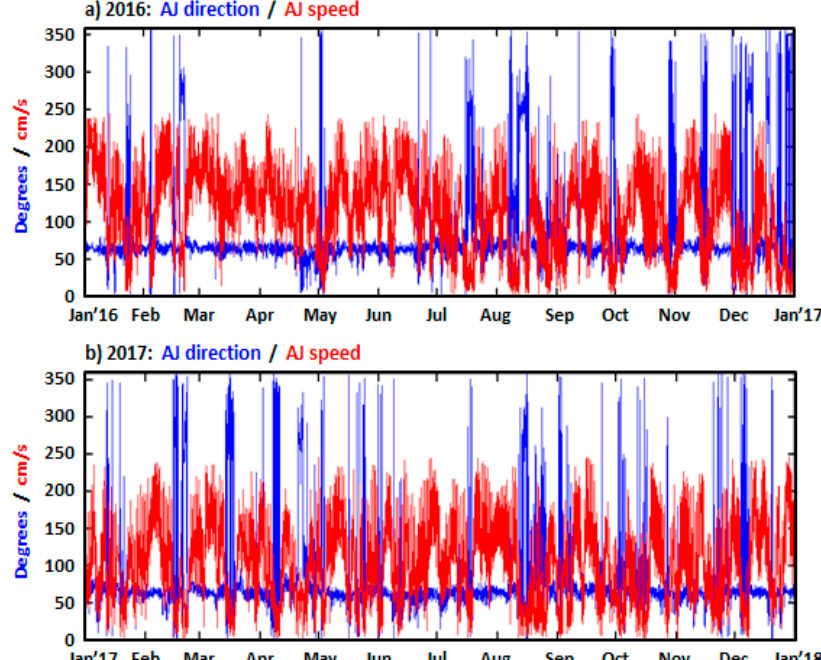
Figure 5. Annual evolution of the AJ orientation (blue line) and current speed (red line) for ( a ) 2016 and ( b ) 2017, as derived from hourly HFR estimations at the midpoint of the selected transect in the Strait of Gibraltar (Figure 1b).